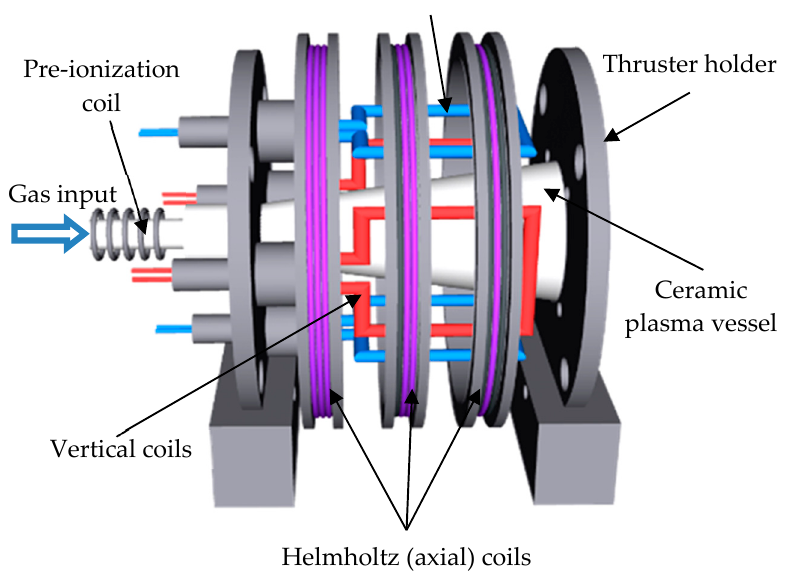
Figure 16. PSAC / SPC prototype of the rotamak-like plasma Figure 16. PSAC/SPC prototype of the rotamak-like plasma thruster.